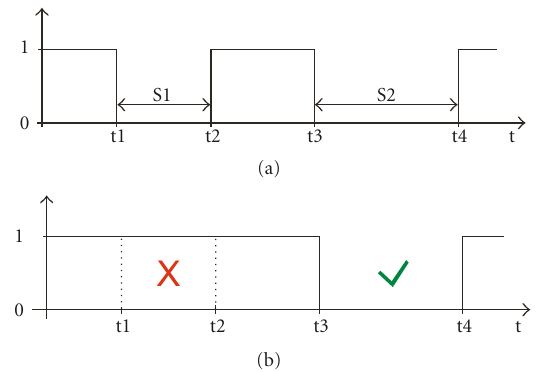
Figure 6: An example of segmentation procedure; (a) marking the potential segments, (b) refuting the unsuitable and confirming the suitable segments (speech = 1, music = 0).